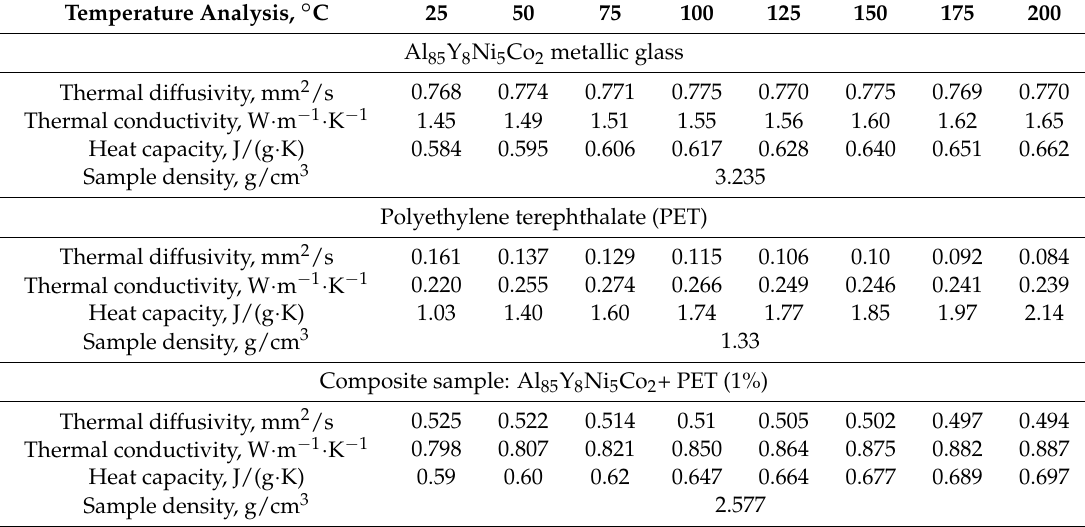
Table 2. Thermal properties and densities of the obtained